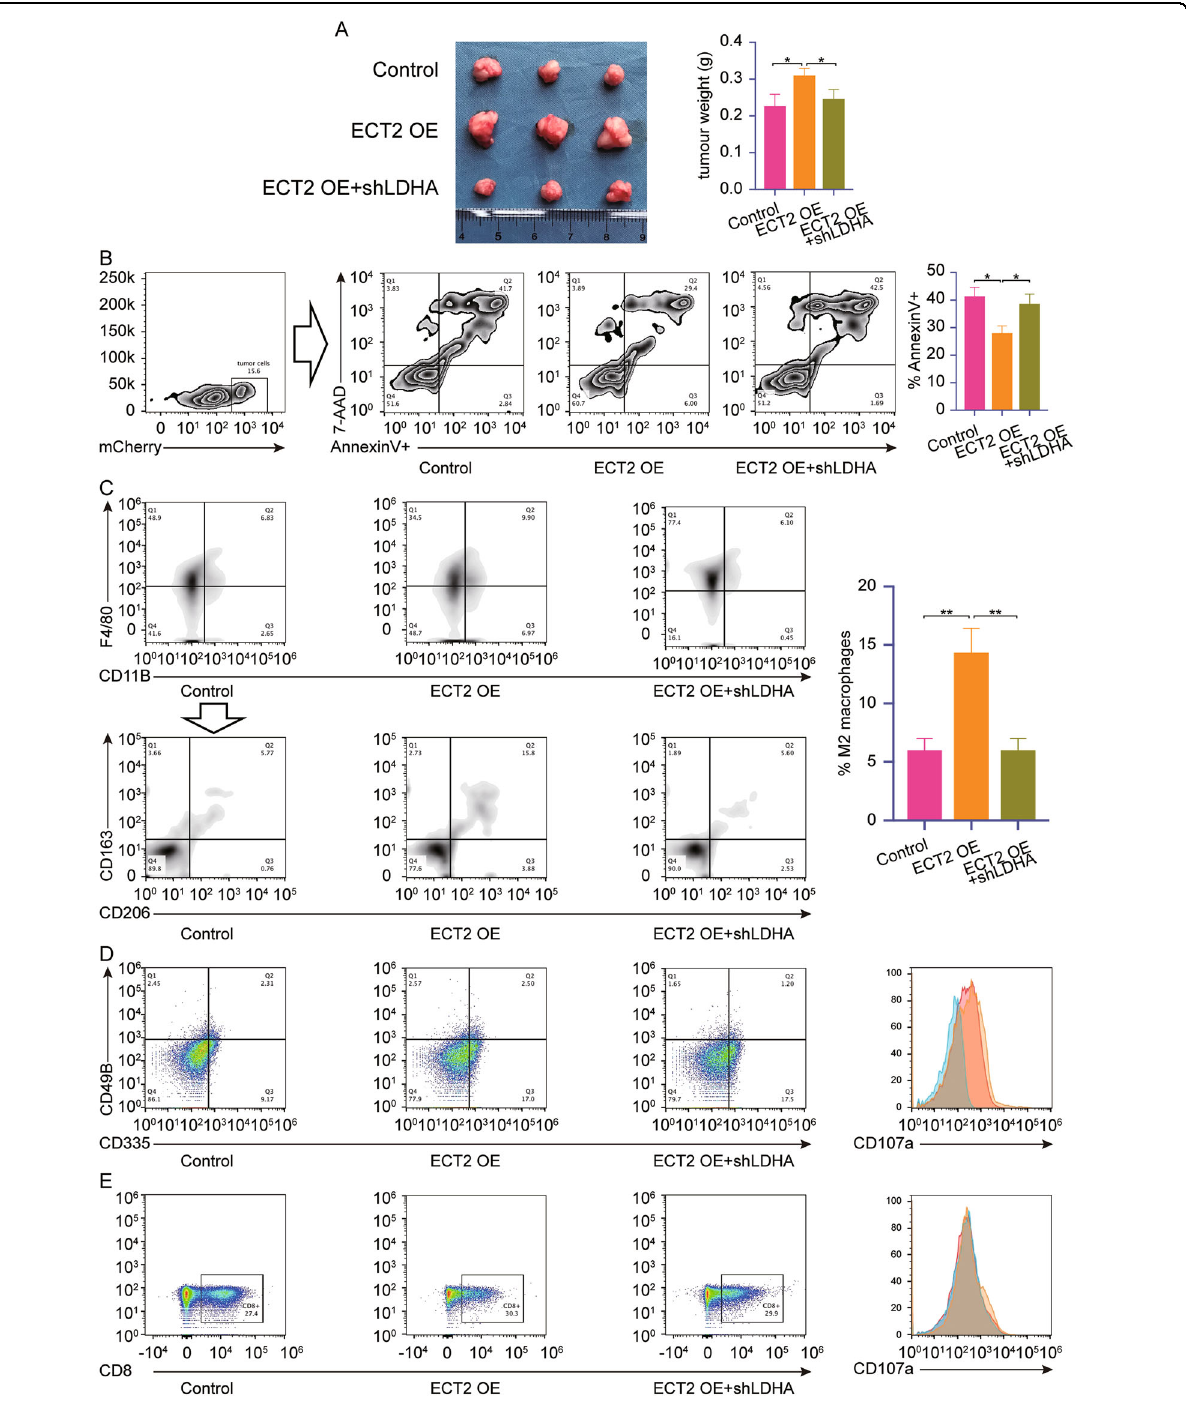
Fig. 8 Downregulation of ECT2 inhibits M2 macrophage in fi ltration in vivo. A Weight of tumors isolated from mice with H22 injections ( n = 3). B Apoptosis of tumor cells gated as mCherry + . C M2 macrophage in fi ltration was evaluated by fl ow cytometry. D NK cell in fi ltration was evaluated. CD107a expression is shown in the right panel. Red: control group, orange: ECT2 OE + shLDHA group, blue: ECT2 OE group. E T cell in fi ltration was evaluated. CD107a expression is shown in the right panel. Red: control group, orange: ECT2 OE + shLDHA group, blue: ECT2 OE group. Error bars represent means ± SD. * p < 0.05, ** p < 0.01. N means “ not signi fi cant ” by paired two-sided Student ’ s t